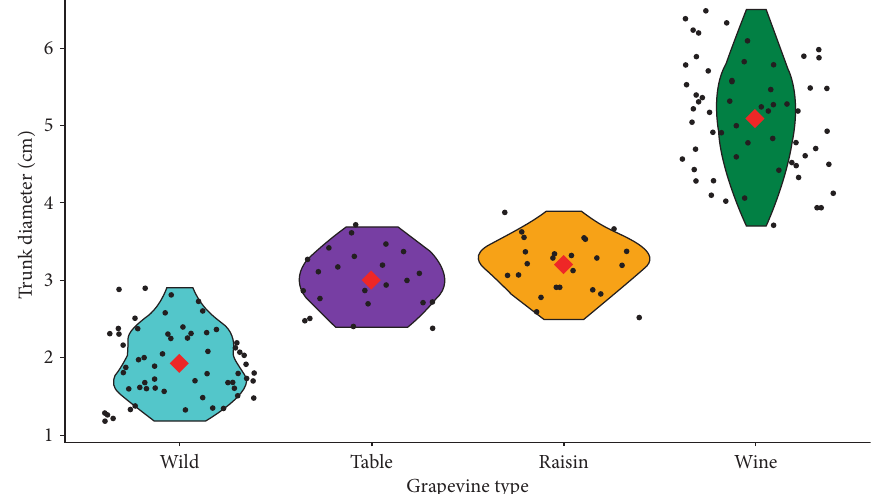
Figure 4: Trunk diameter variation among grapevine